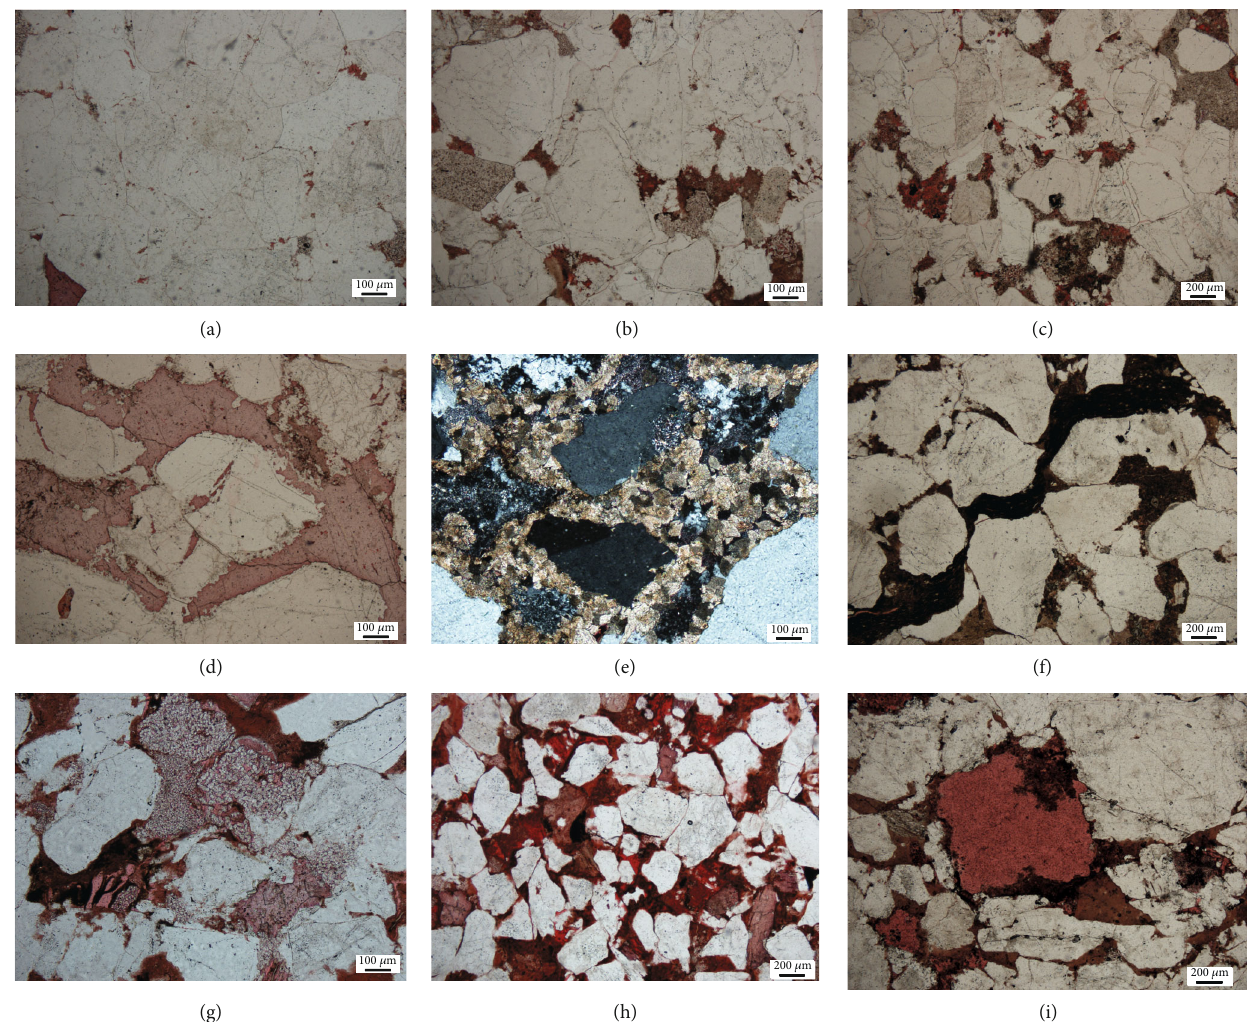
Figure 3: Main diagenesis types of the main gas interval in the western Sulige gas fi eld. (a) Compaction and cementation (e18 Well, 3604.89m); (b) secondary enlargement of quartz (s146 Well, 3554.7m); (c) siliceous cementation (s245 Well, 3655.36m); (d) ferrocalcite (s245 Well, 3585.7m); (e) ferrodolomite cementation (e18 Well, 3697.17m); (f) ferruginous and argillaceous cementation (s68 Well, 3634.06m); (g) replacement of feldspar (s244 Well, 3552.61m); (h) intergranular dissolved pores (c1 Well,3515.85m); (i) dissolved pore of detritus (s75 Well,